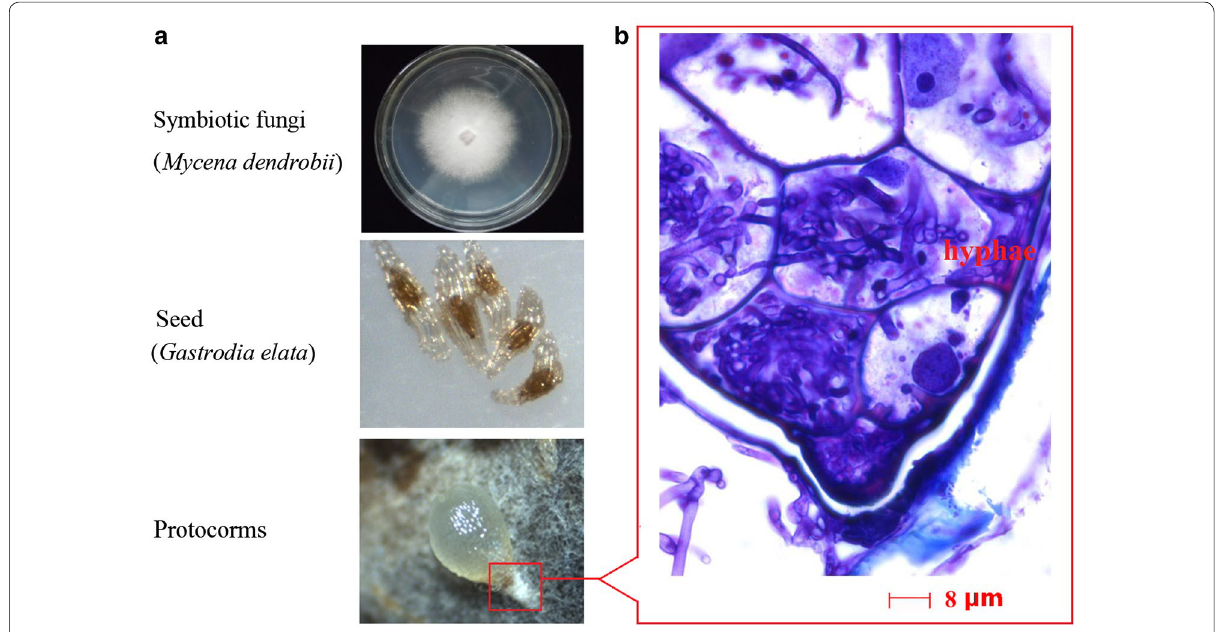
Fig. 1 Biomorph of seed germination of Gastrodia elata. a M. dendrobii incubated on the fresh PDA; the mature seeds of G. elata ; the typical proto- corm of G. elata infected with M. dendrobii ; b histological observation of the protocorms